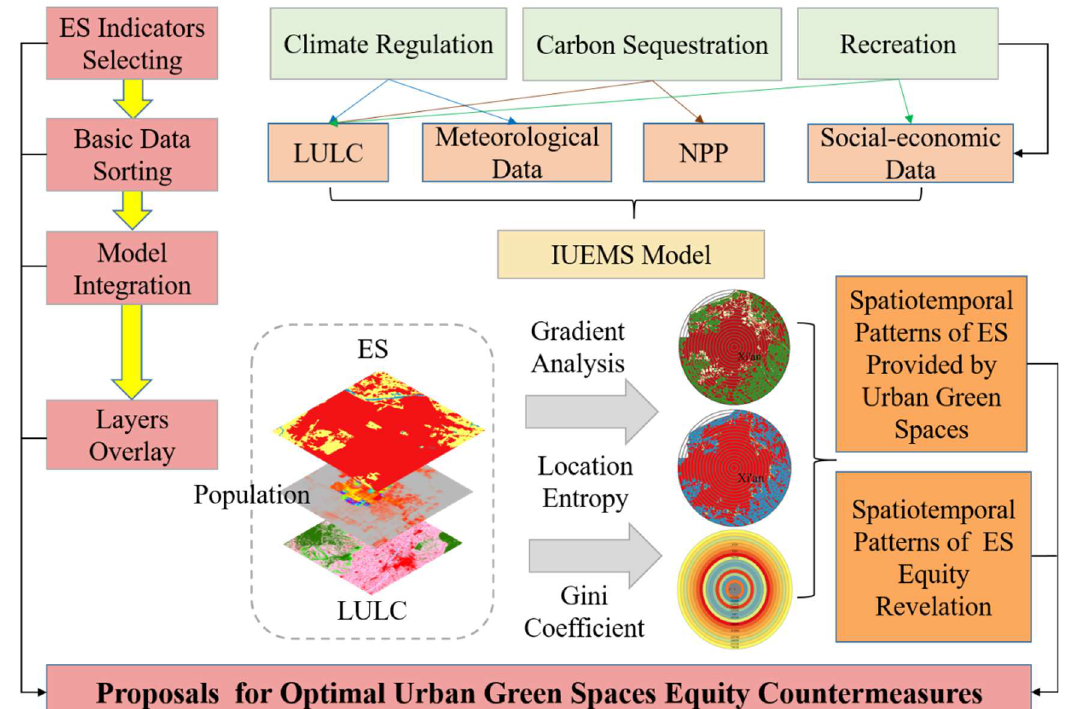
Figure 2. The research framework of the spatio-temporal patterns of ecosystem services provided by urban green spaces and their equity evaluation.